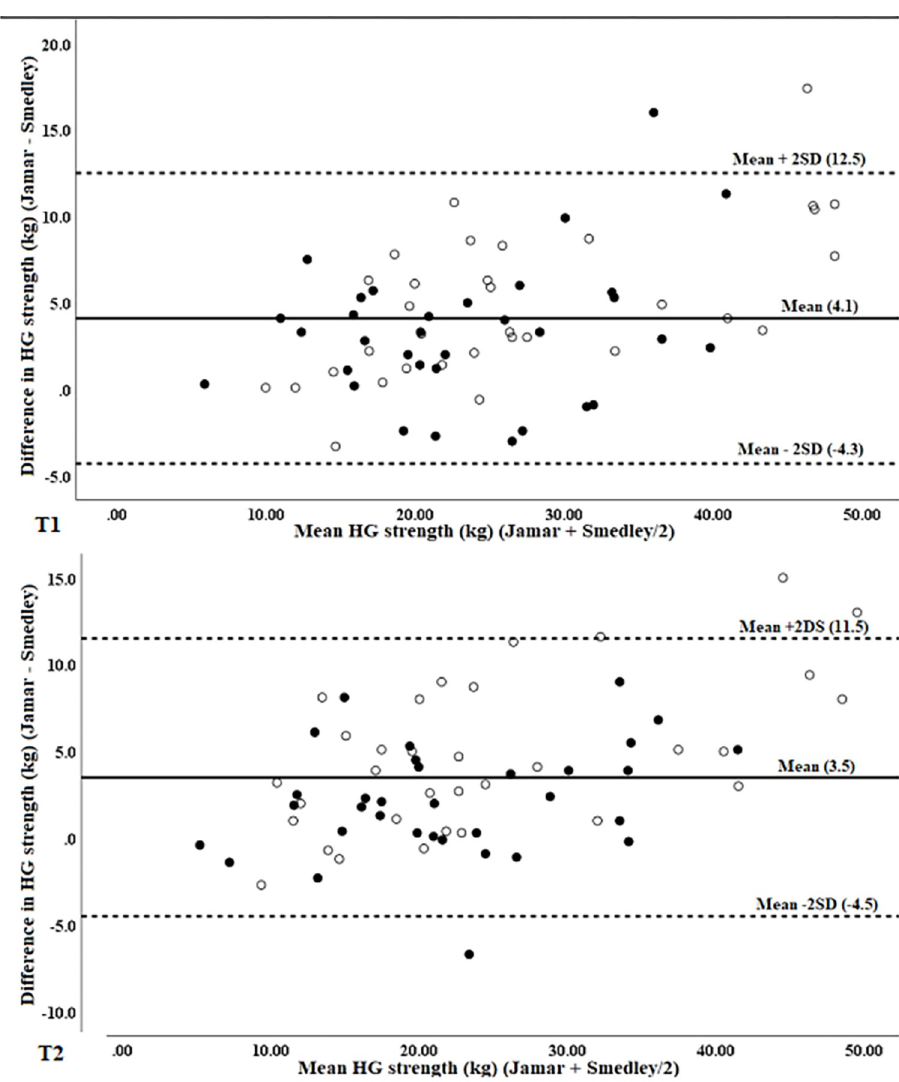
Fig 4. Bland-Altman plots for differences against mean values of hand grip strength measured with the Jamar and Smedley dynamometers at T1 (top) and T2 (bottom) stratified by age. (young-old = empty circles, old-old = solid